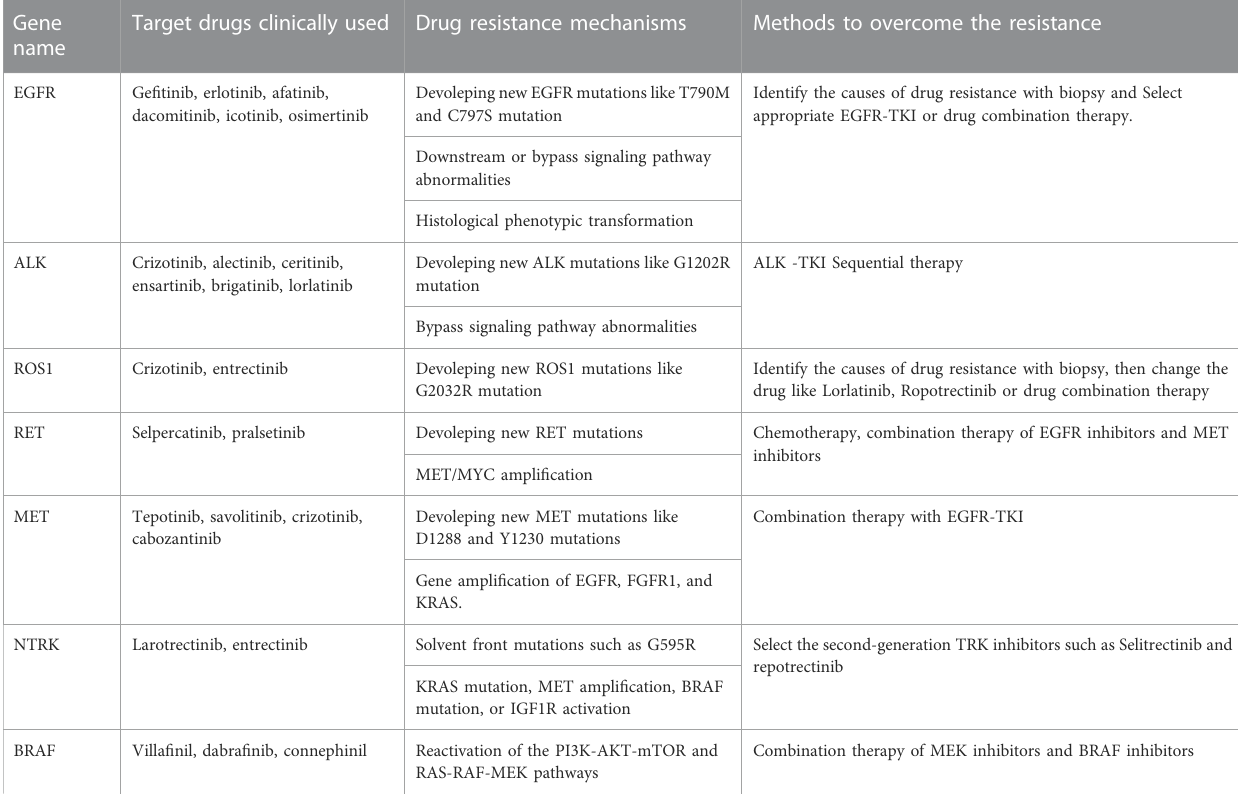
TABLE 1 Resistance mechanisms of approved targeted